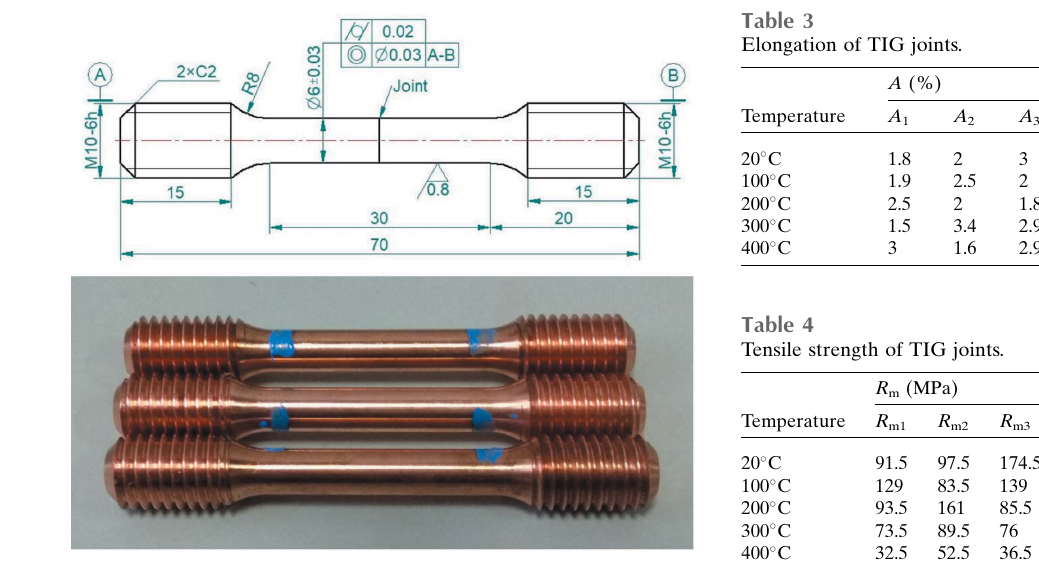
Figure 1 Tensile specimen (units: